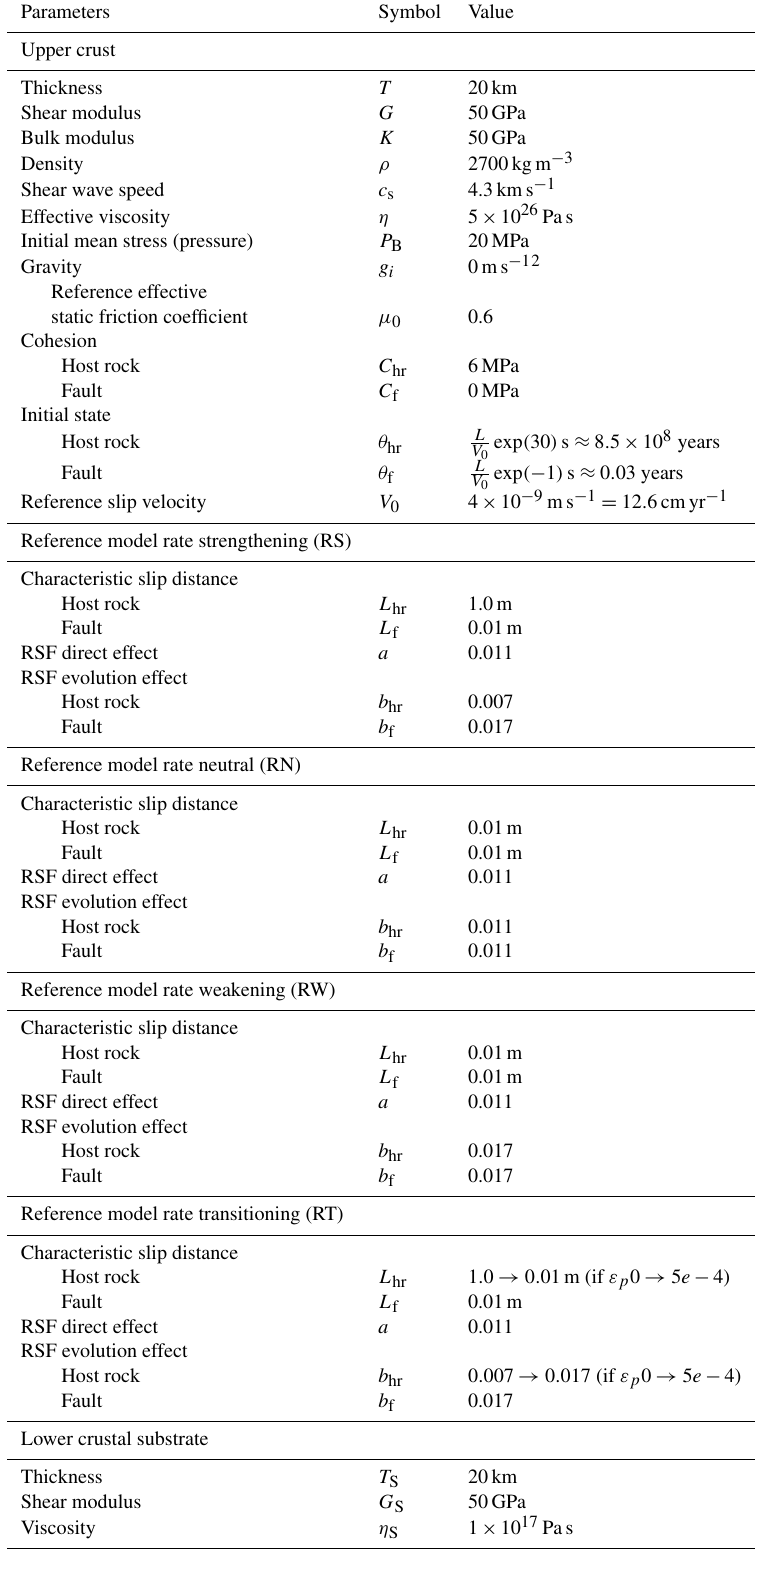
Table 1. Rate- and state-dependent friction (RSF) and material parameters of the four 2.5-D reference models.